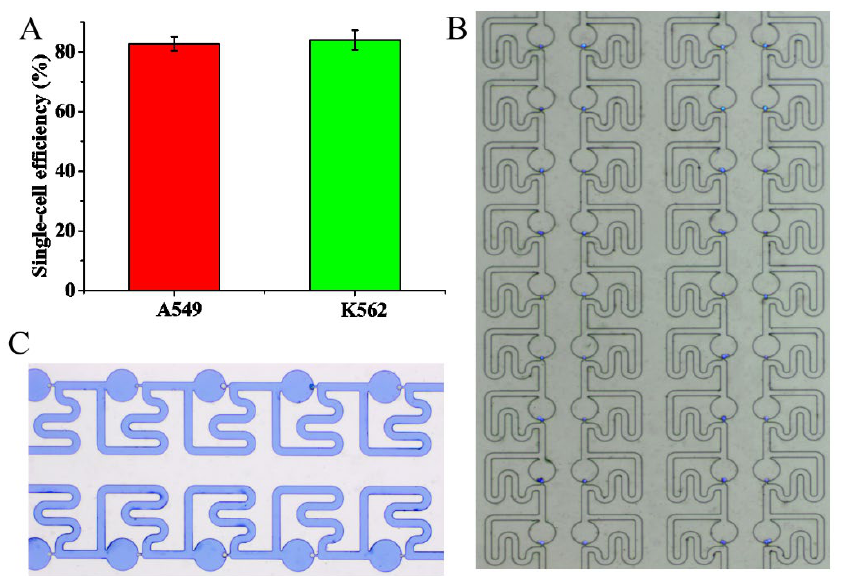
Figure 6. Single-cell trapping on the proposed chip. ( A ) Average single-cell trapping efficiency for A549 and K562 ( N = 3 for each cell line). ( B ) The image of single-cell trapping and stained with DAPI, in which cells appeared as blue. ( C ) Measurement of cell viability using trypan blue staining. Trypan blue stained dead cells